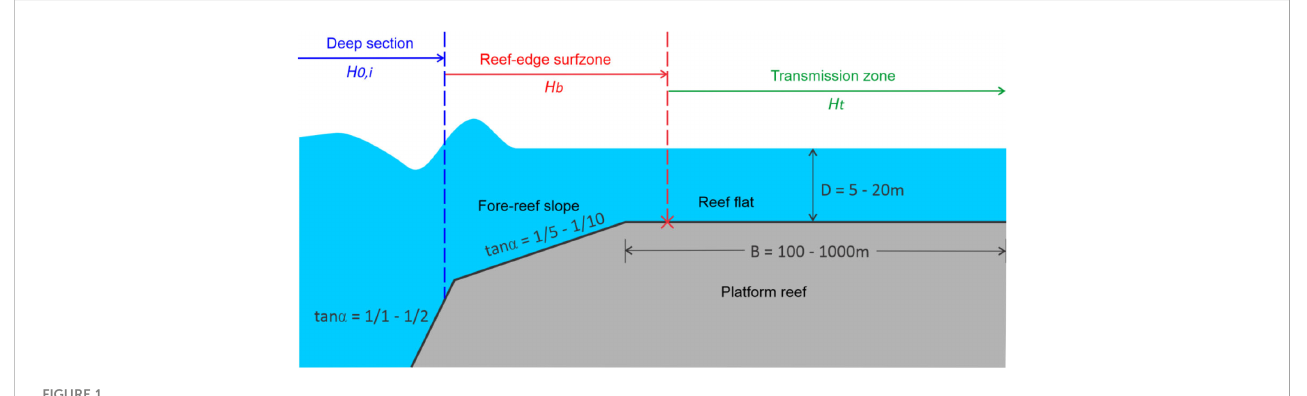
FIGURE 1 Geometrical features of the submerged reef (original